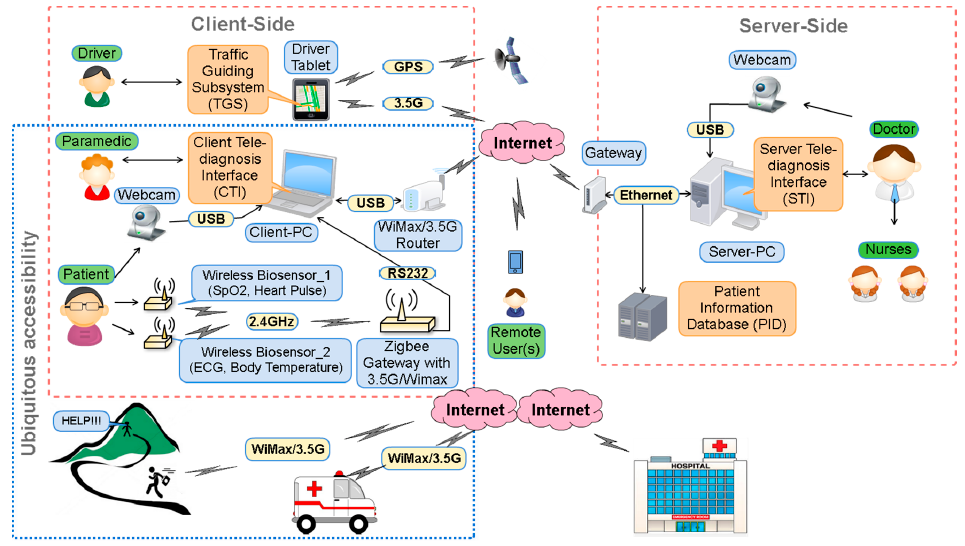
Figure 1. Framework of the proposed system.